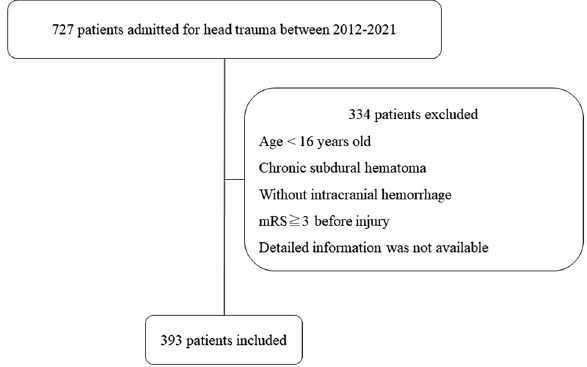
Figure 1. Schematic drawing of patient selection